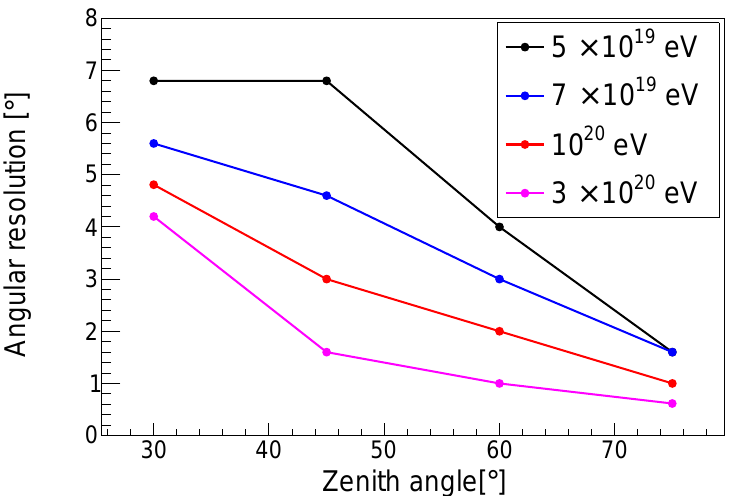
Figure 13. Estimated angular resolution of K-EUSO for different zenith angles and energies of a primary particle in the full field of view of the